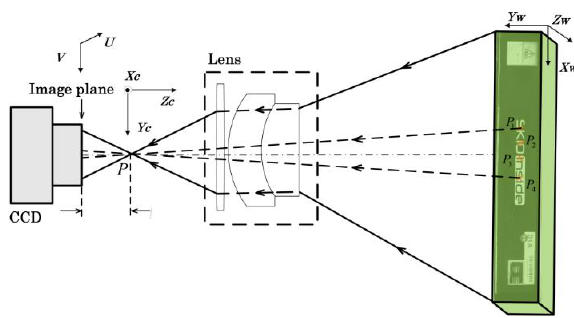
Figure 2. Schematic diagram of the imaging model of the pose-estimation system.